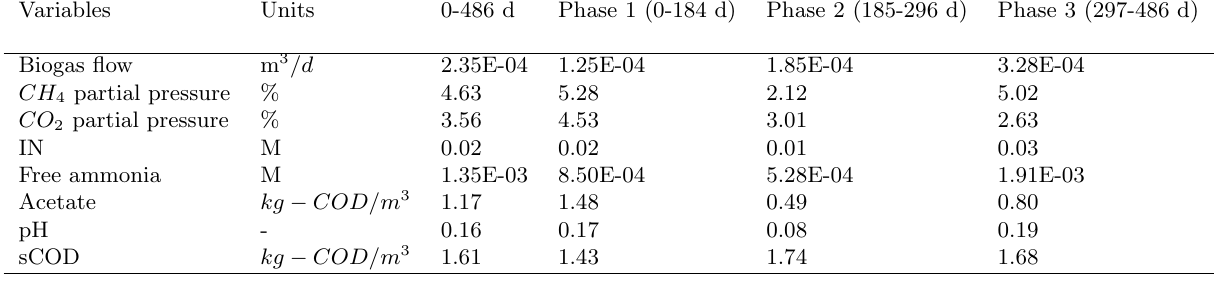
Table 5: Calculated RMSD for the simulation and experimental results for the entire 486 d experiment and for phase 1-3 with distinctly different operational